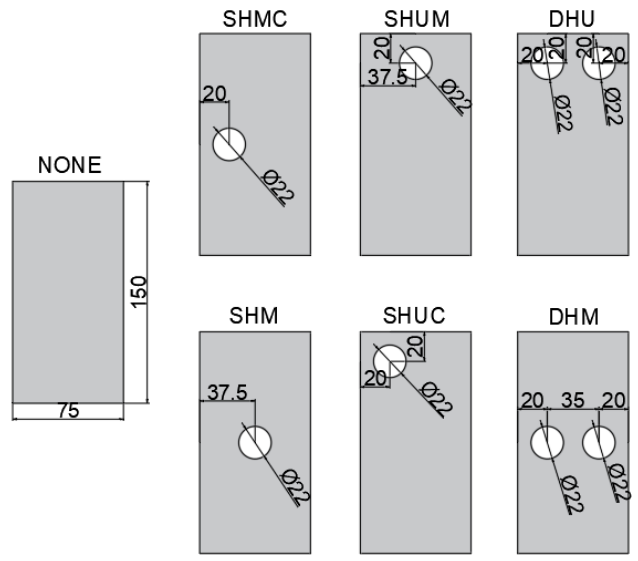
Figure 1. Specimens with same opening size with different location, dimensions are mm. Table 2. Material properties of FRP fabrics.